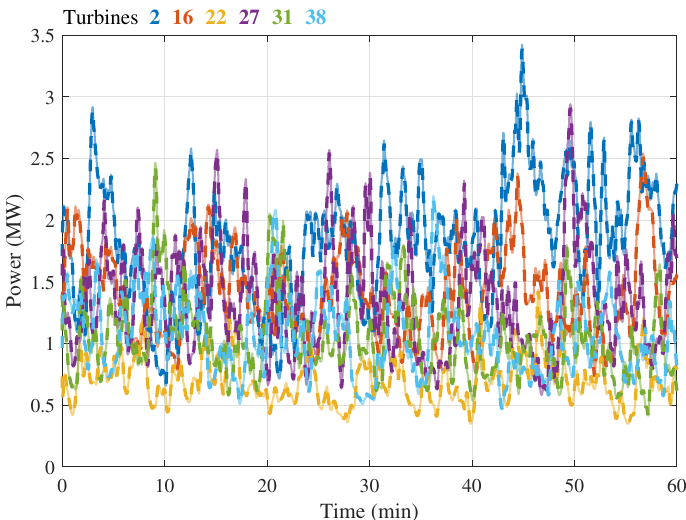
Figure 8. Measured (——)and estimated power production (– – –) for the 38-turbine wind farm. The turbine locations are shown in Figure 7.